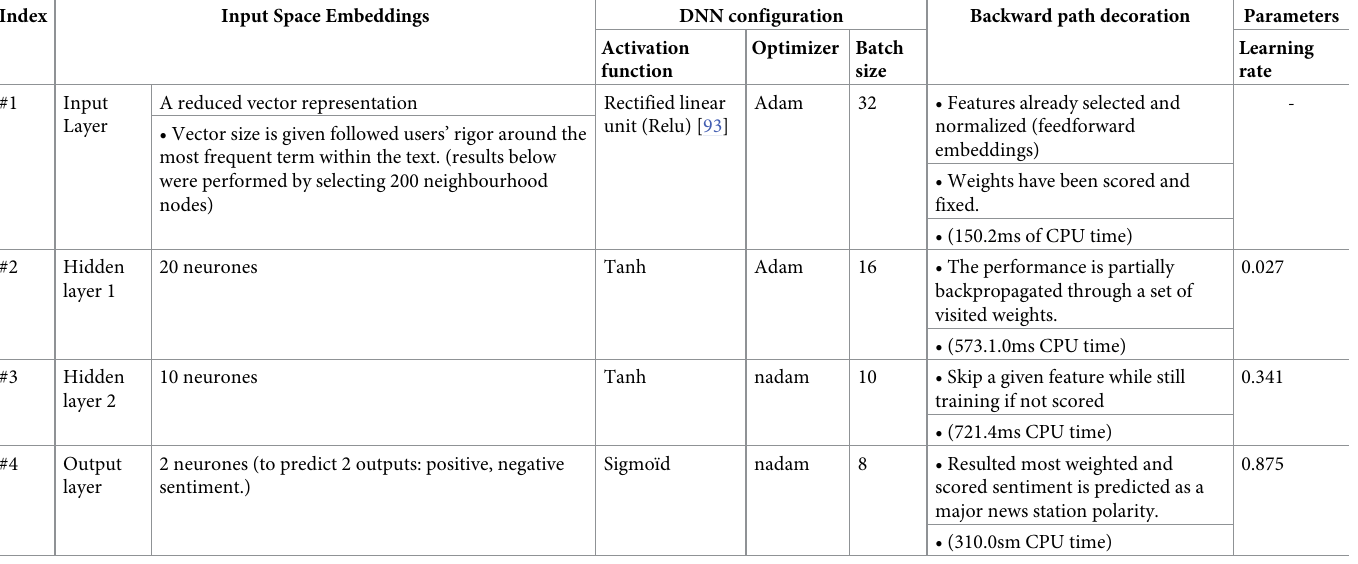
Table 4 details the parameters of the DNN structure depicted by Fig 12, the batch size of each hidden layer, the activation functions, the optimizer, and the estimated learning rate of each layer. Table 4. Inner structure parameters of the proposed DNN compared to basic